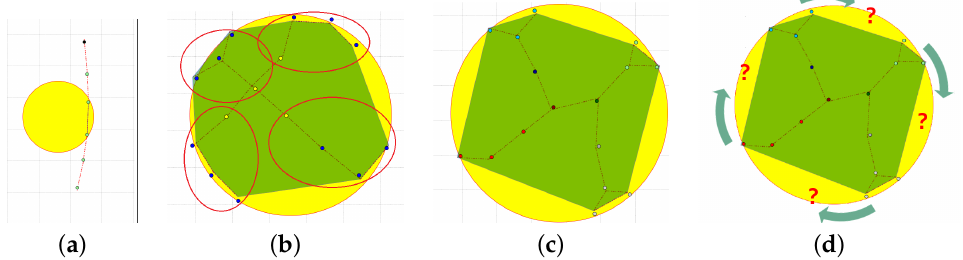
Figure 2. Gas cloud detection and monitoring: ( a ) Stage 1 completed ( b ) Stage 2: clusters ( M = 4) and temporal topology, ( c ) Stage 2 completed, ( d ) Stage 3: potential direction of boundary